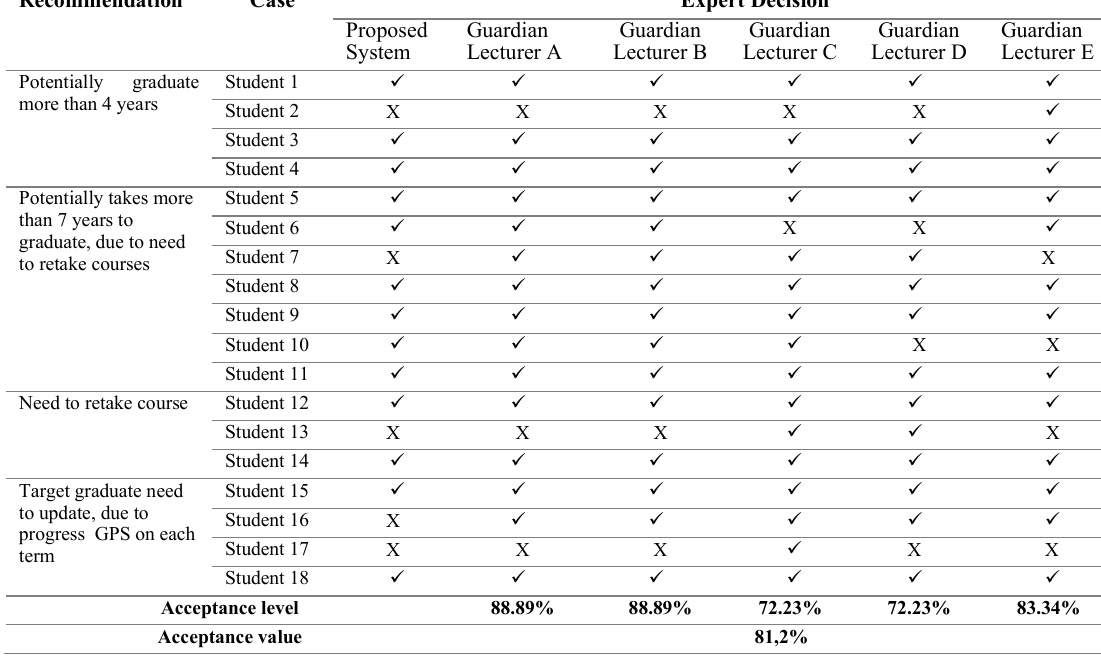
TABLE 3 COMPARATION OF RECOMMENDATION RESULT AS THE CONFORMITY